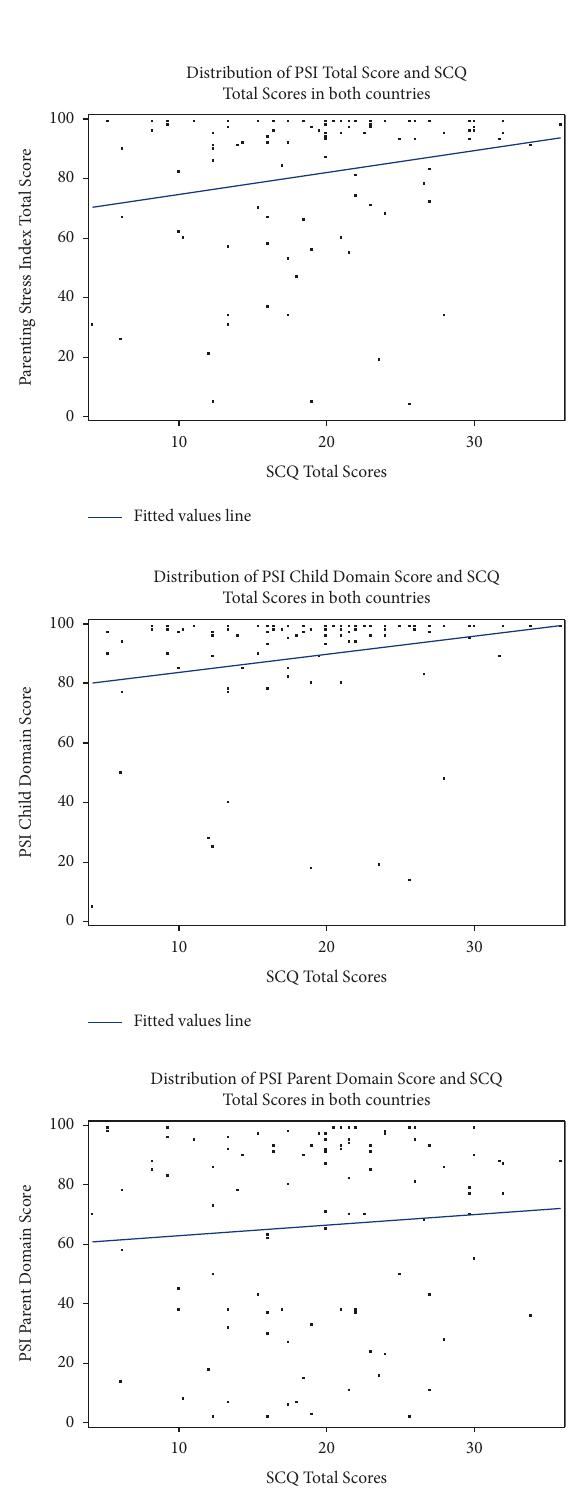
Figure 1: Distribution of the parenting stress index (total, child, and parent domains) and the social communication questionnaire score in combined U.S. and Japan